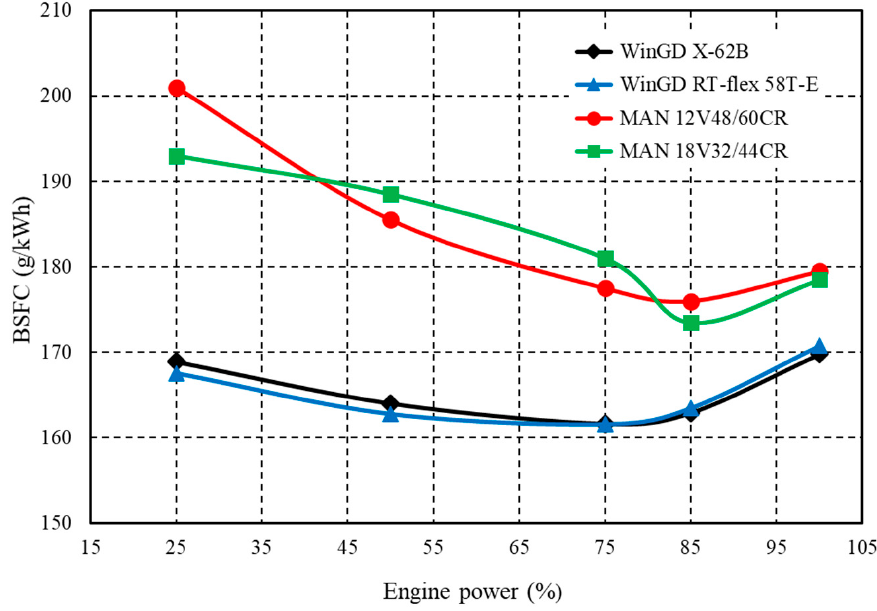
Figure 7. Speci fi c fuel consumption in the range of 25 to 100% MCR (Source: factory data). Figure 7. Specific fuel consumption in the range of 25 to 100% MCR (Source: factory data).